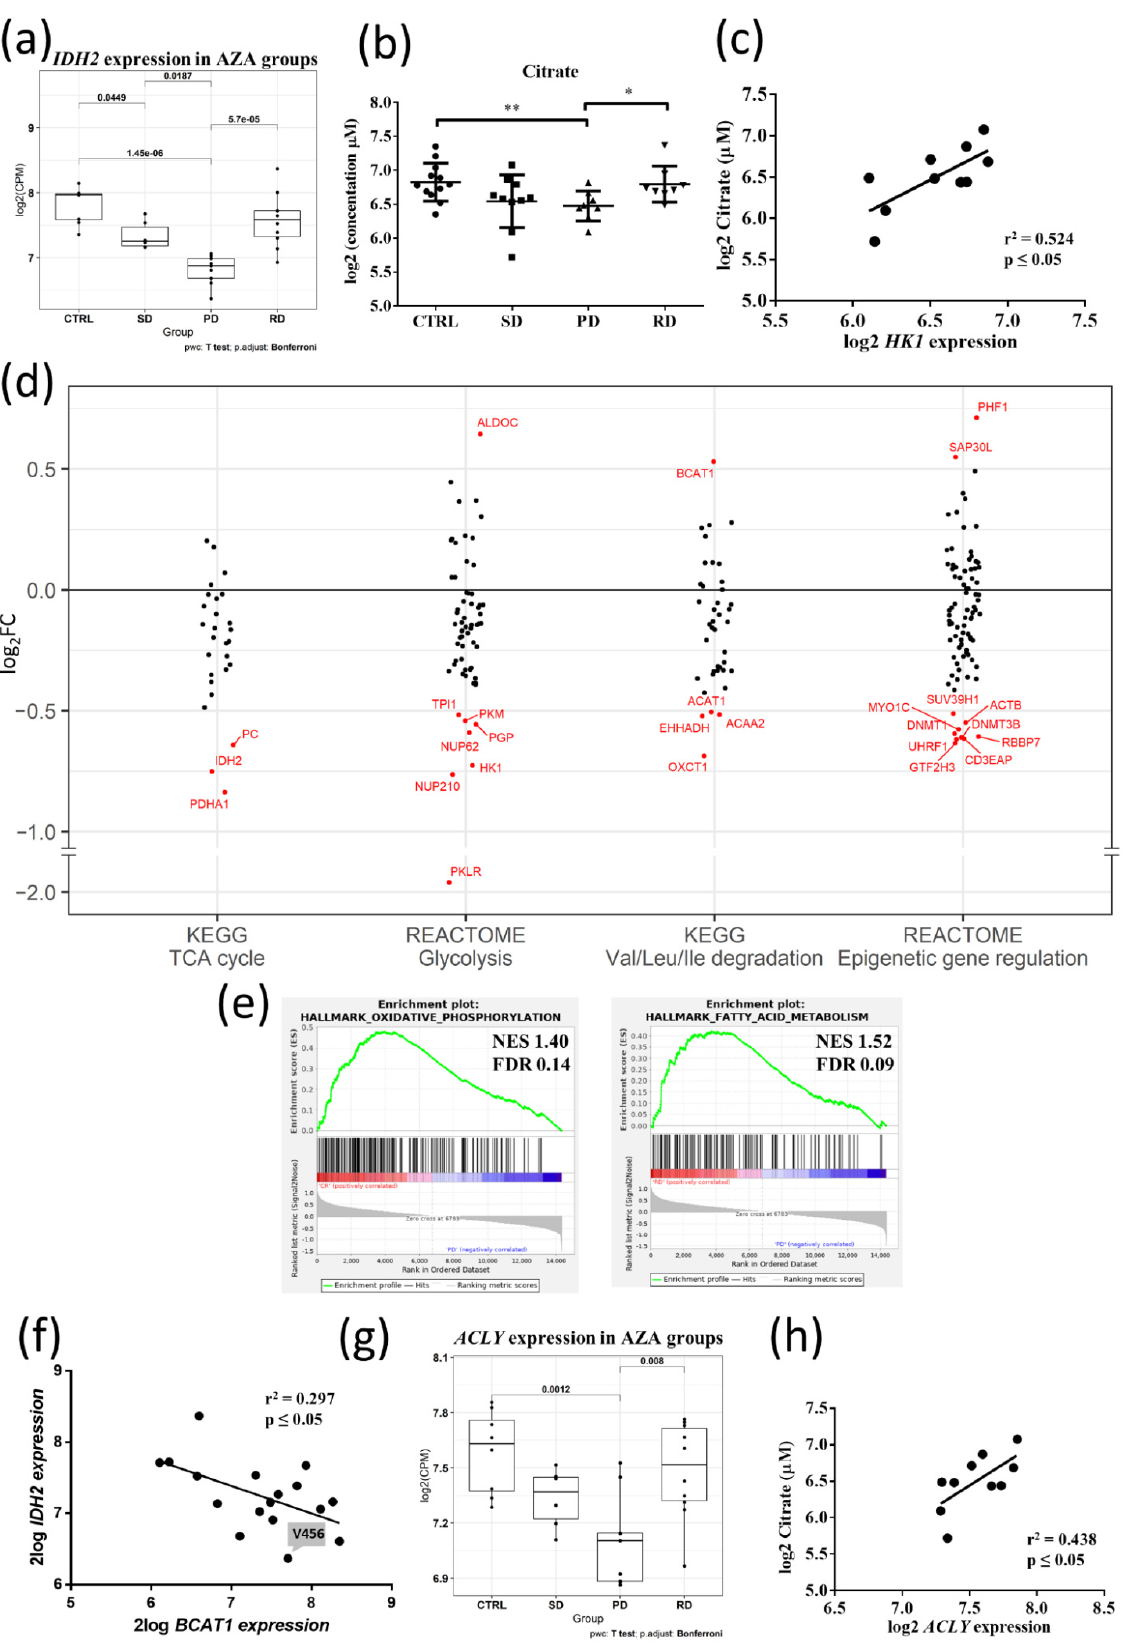
Figure 4. Characterization of metabolic signature of AZA pre-treatment MDS/AML-MRC patients. ( a ) Boxplot showing IDH2 expression in CD34 + hematopoietic stem/progenitor cells (HSPCs) from patients of discovery cohort and